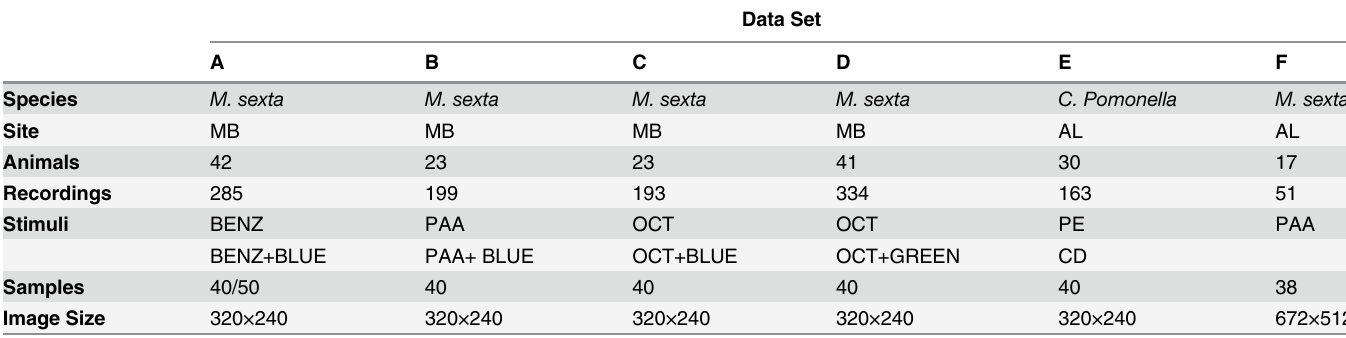
Table 1. Overview of the data sets